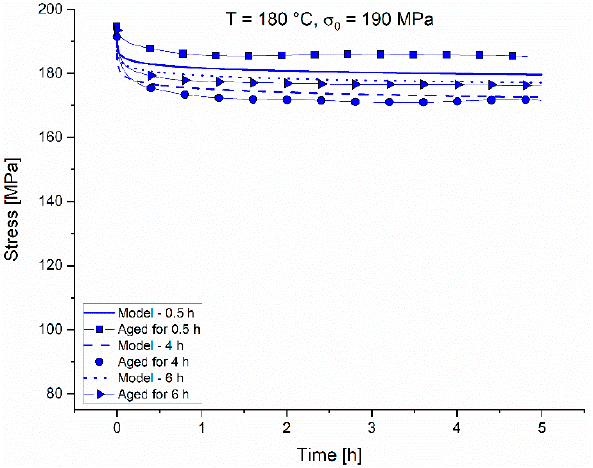
Figure 13. Comparison of experimental and simulated stress relaxation curves tested in aged con- dition at 180 °C with test stress of 190 MPa.